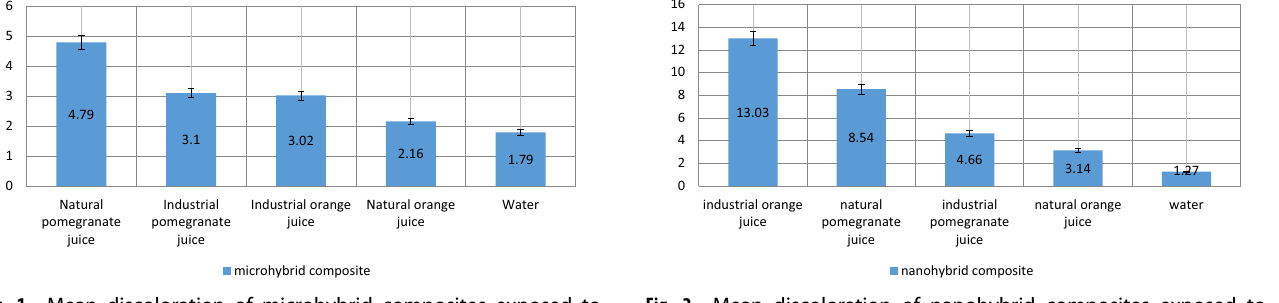
Fig. 2 Mean discoloration of nanohybrid composites exposed to different